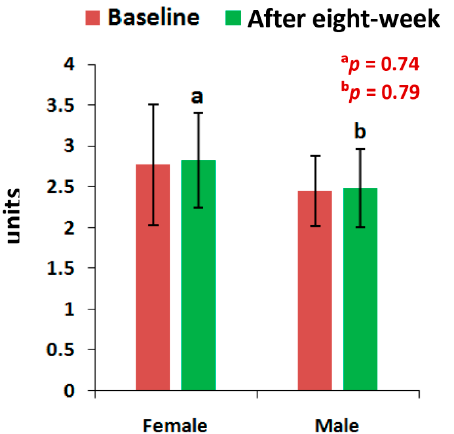
Figure 5. Levels of Calcium-to-Phosphorus ratio of 45 control subjects, female ( n = 27) and male ( n = 18), before and after eight ‐ week without using supplement ( ᵃ p = 0.74, ᵇ p = 0.79).